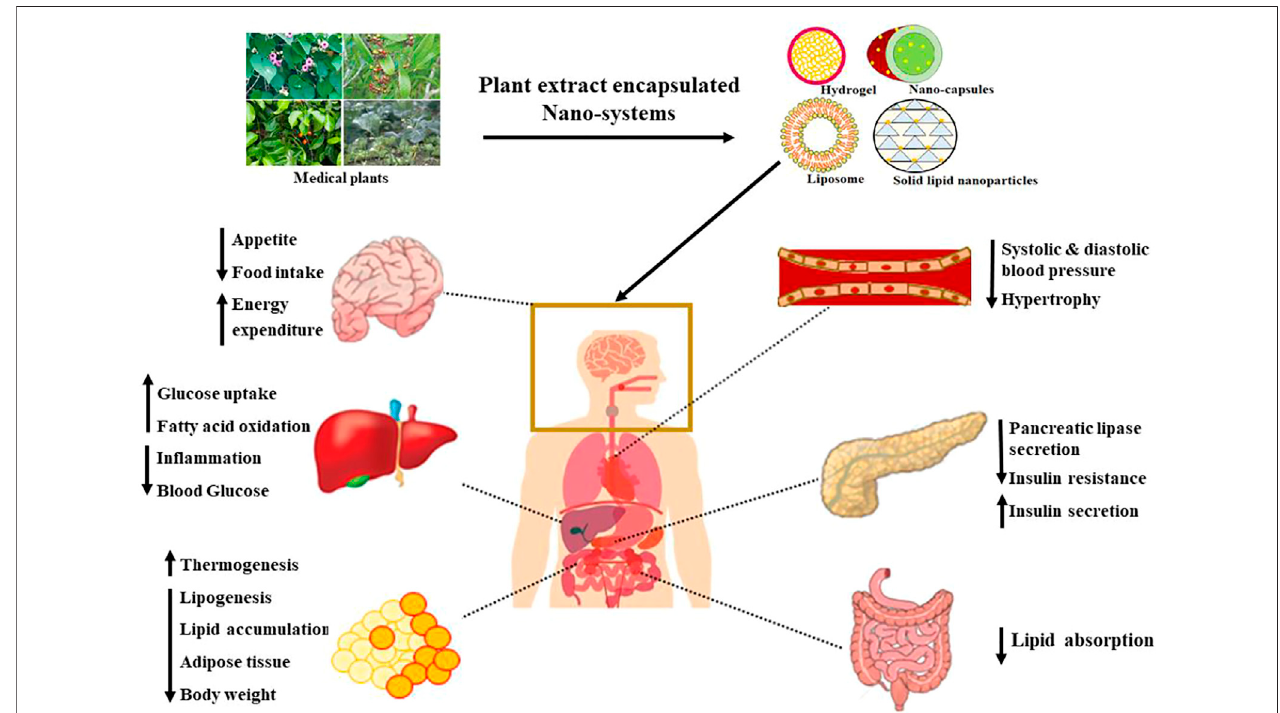
FIGURE 3 | Importance of plant-extract-encapsulated nanosystems for metabolic disorders.